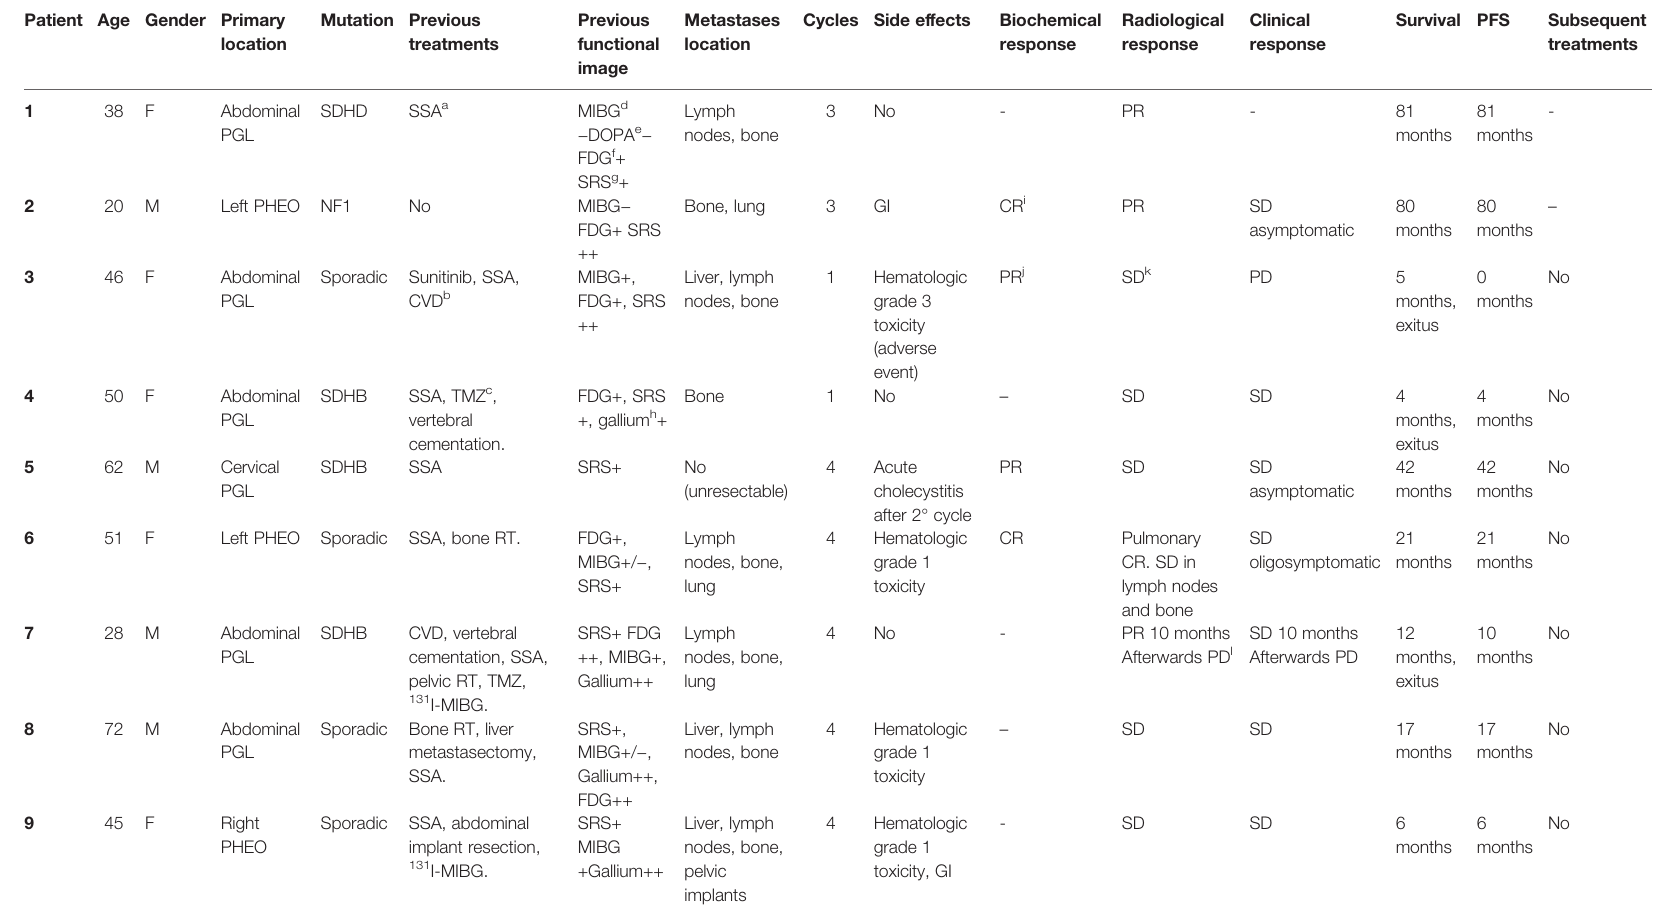
TABLE 2 | Patient characteristics in [ 177 Lu]Lu-DOTA-TATE treatment. Patient Age Gender Primary